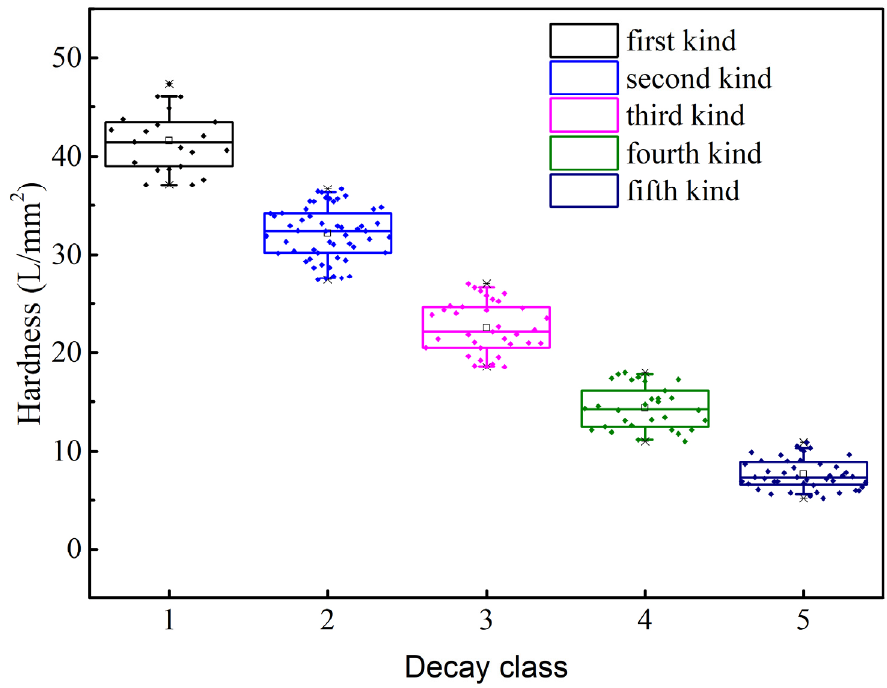
Figure 4. The projections of the different ranges of hardness values among the different decay classes. The total number of samples involved in clustering was 184.